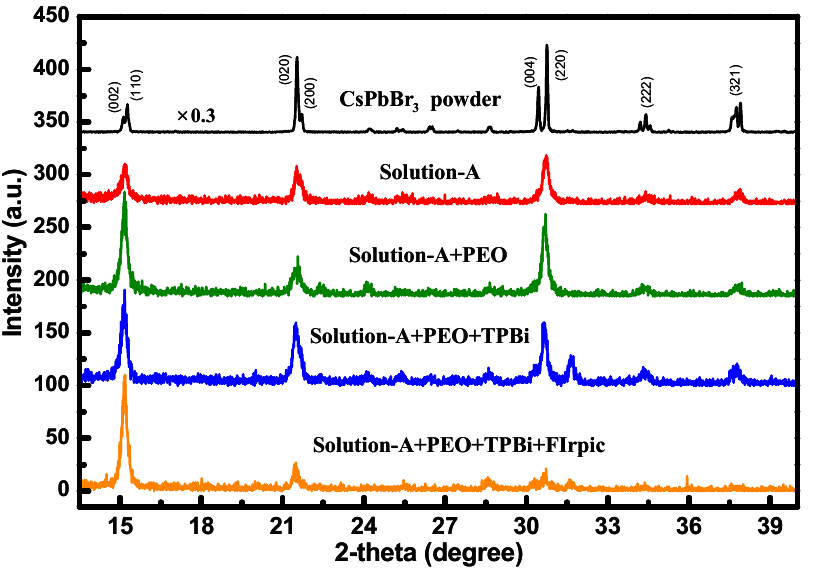
Figure 3. XRD patterns of EMLs derived from various precursor solutions.